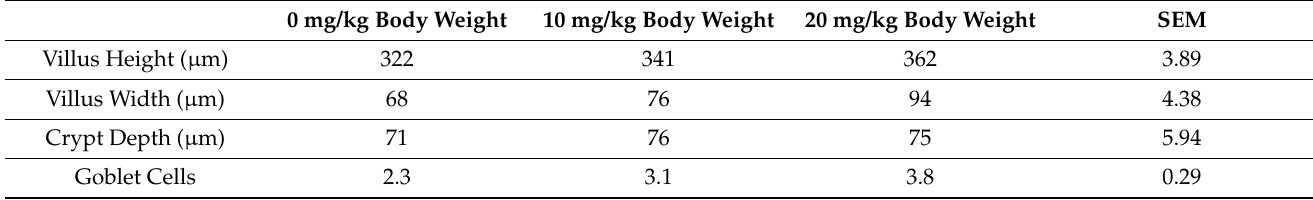
Table 3. Morpho-characteristics of mice jejunum treated with different concentration of Heracleum persicum .